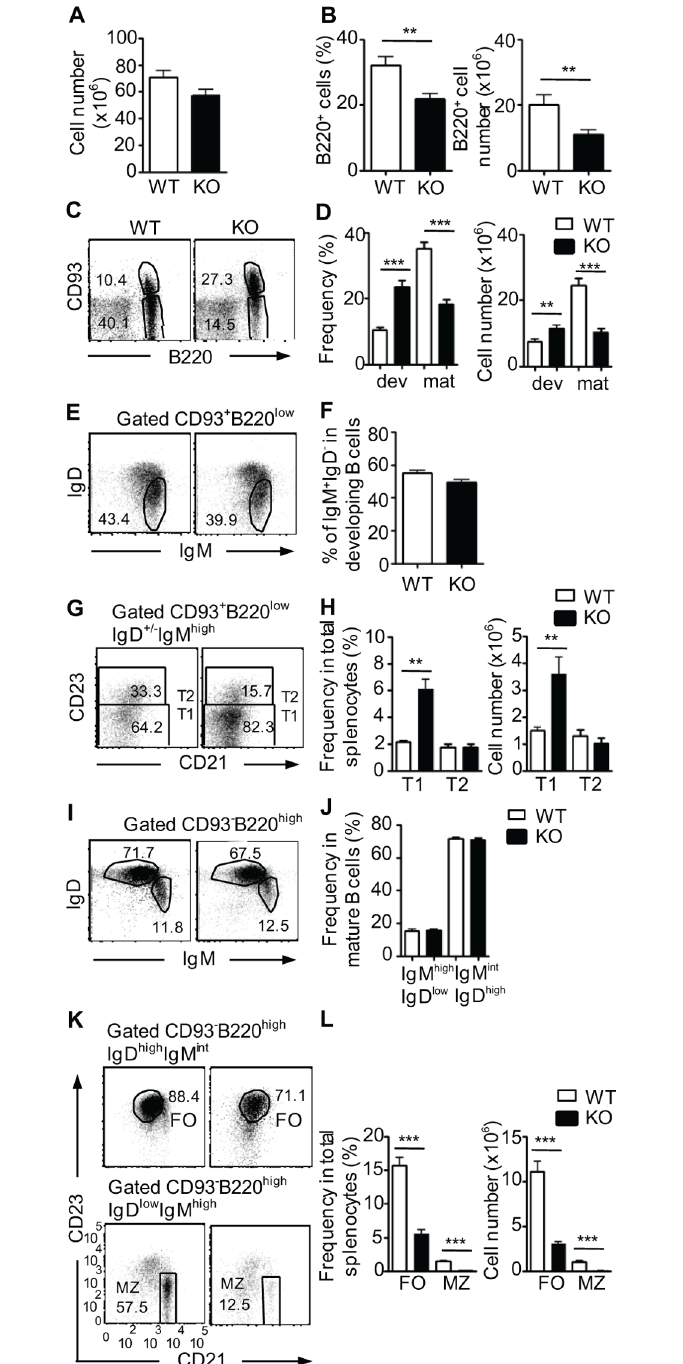
Fig 2. Effect of TSC1 deficiency on B cell development in the spleen. (A) Total splenocyte number in WT and TSC1KO mice. (B) Percentage (left panel) and total B cell numbers (right panel) in WT and TSC1KO spleens (n = 10). (C, D) Decreased mature but increased immature B cells in TSC1KO spleen. Dot plots show CD93 and B220 staining of splenocytes (C). Bar graphs show percentage (left panel) and absolute numbers (right panel) in WT and TSC1KO spleens (D). (E, F) IgM and IgD expression in CD93 + B220 low compartment. (G, H) Increased T1 B cells in TSC1KO spleen. Dot plots show CD21 and CD23 expression in gated CD93 + B220 low IgM high IgD +/- cells (G). Bar graphs show percentages and absolute numbers of T1 and T2 B cells (H). (I, J) IgM and IgD expression in CD93 - B220 high cells. (K, L) decreased mature B cells in TSC1KO